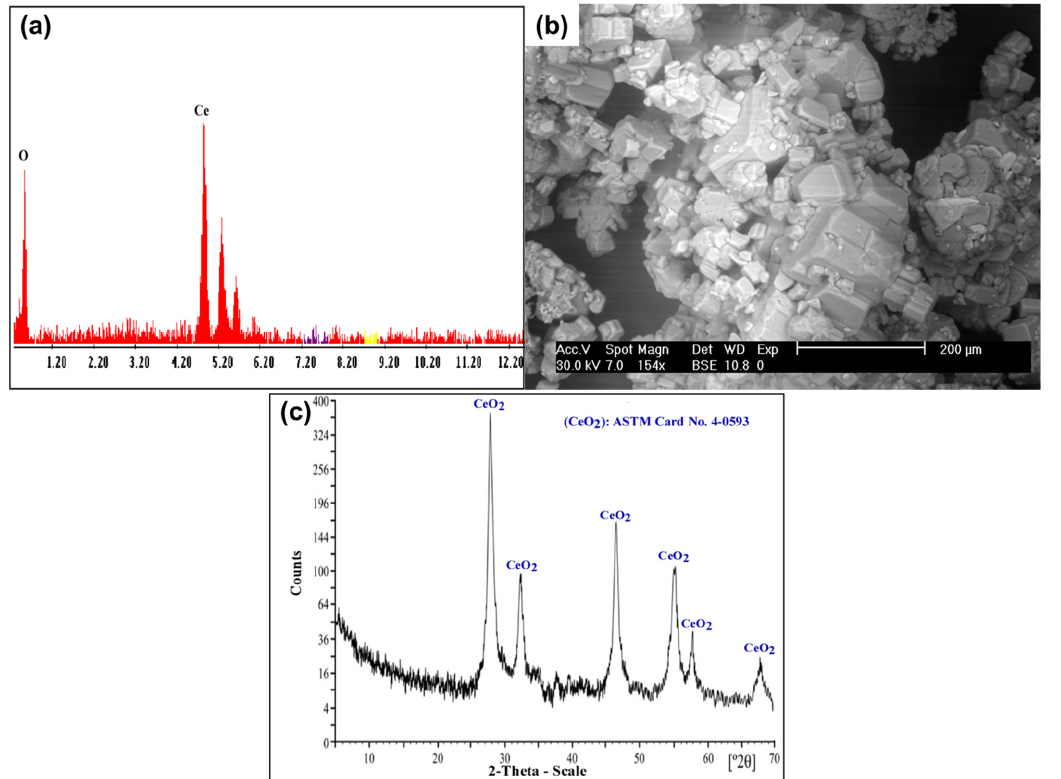
Figure 16. ( a ) EDX spectrum of CeO 2 product; ( b ) SEM image of CeO 2 product; ( c ) XRD spectrum of CeO 2 product. Figure 16. ( a )EDXspectrumofCeO 2 product;( b )SEMimageofCeO 2 product;( c )XRDspectrumofCeO 2